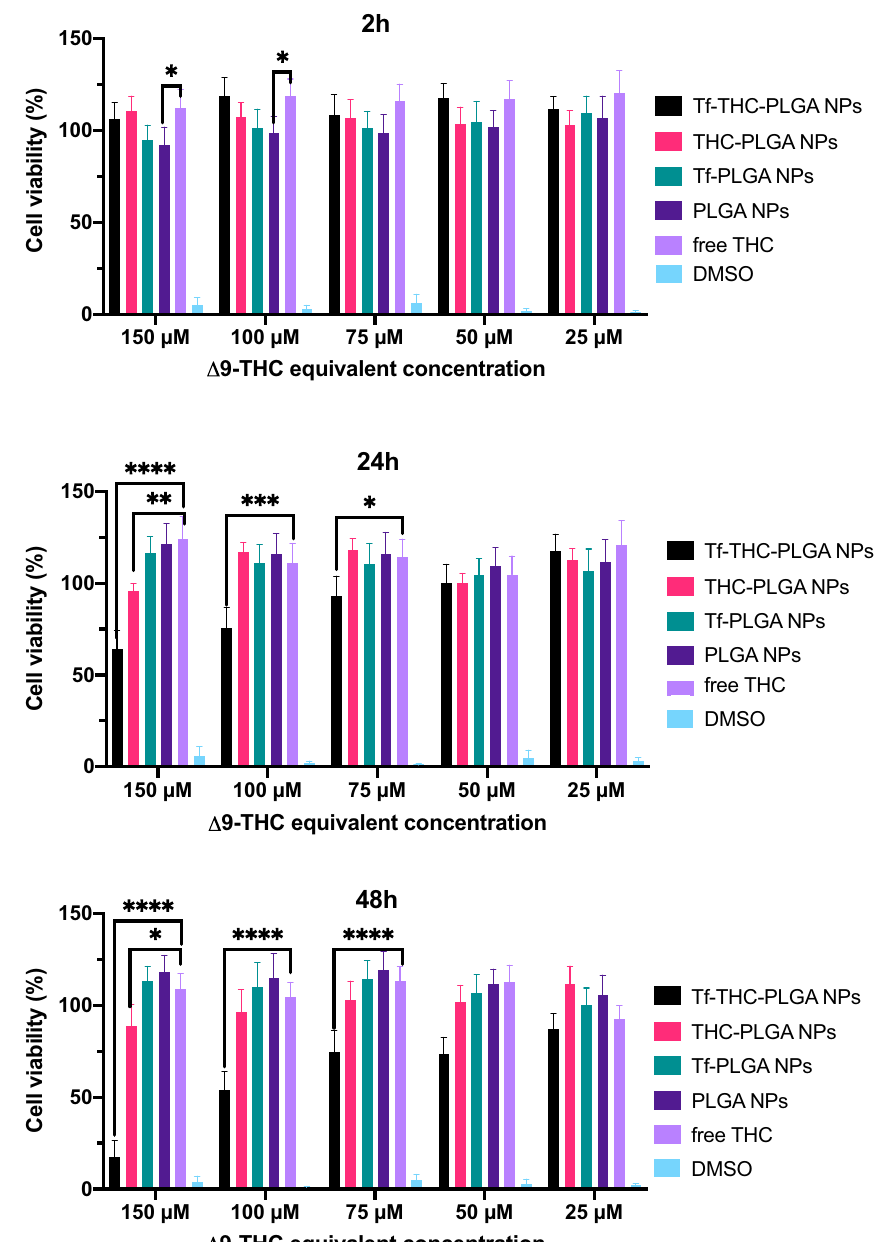
Figure 3. MTT data obtained after 2 h, 24 h and 48 h of incubation. Statistically significant differences in cell viability (%) values are referred to plain PLGA NPs as control group; *p < 0.0332; **p < 0.0021; ***p < 0.0002; ****p <